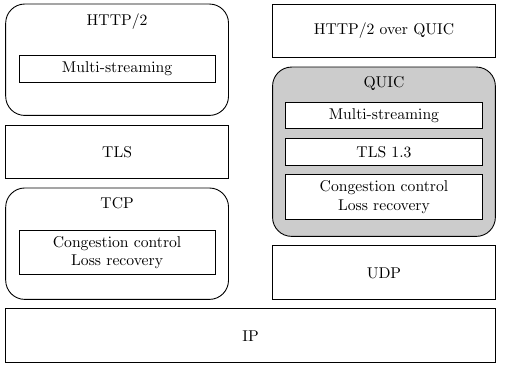
Figure 1. HTTP/2 over TCP and